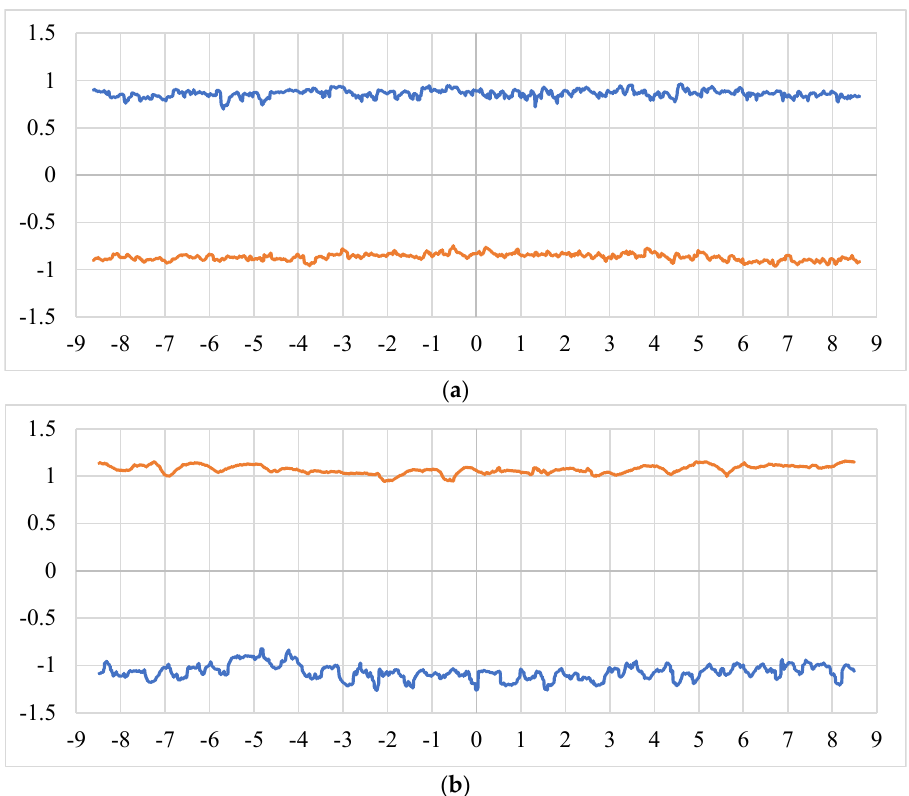
Figure 8. Profiles of the specimen with an orientation of 0°: ( a ) 0° measurement direction; ( b ) 90° measurement direction.